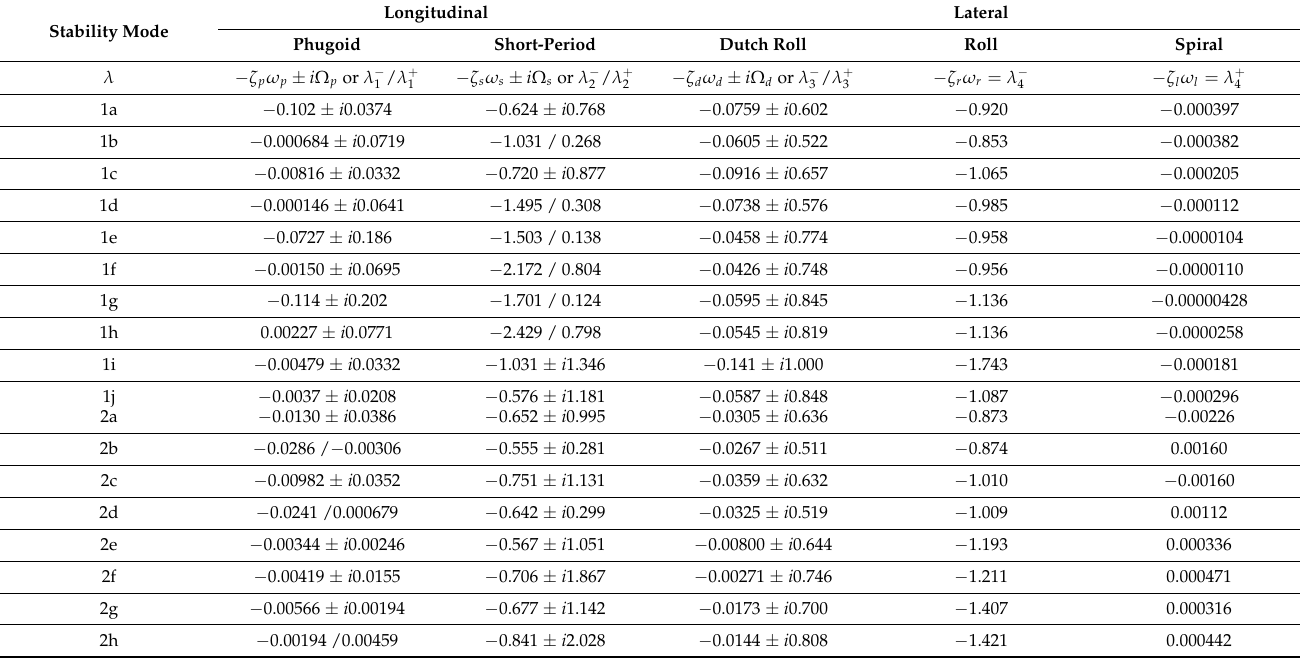
Table 7. Eigenvalues λ ± of natural modes involving the damping ratio ζ , natural ω and oscillation Ω frequencies. Stability